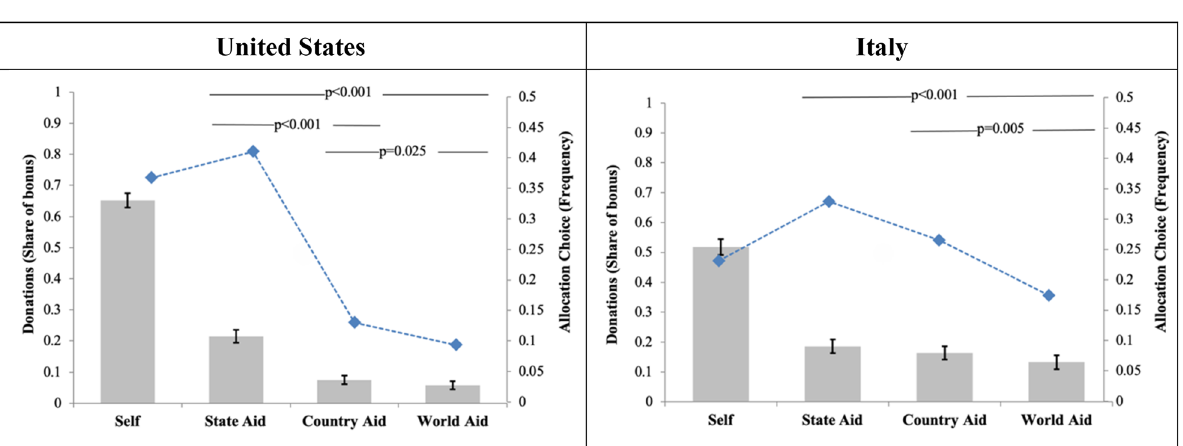
Figure 3. Patterns of bonus allocation. The frequency with which each charity is selected (blue diamonds, scale on the right-hand y-axis) and the mean levels of aggregate donations ( AD ) to each charity and the amount kept for self (bars, scale on left-hand y-axis) are plotted. Whiskers indicate the confidence intervals for mean AD , obtained from bootstrapped standard errors with 10,000 repetitions. The p -values report significance levels of t-tests on the null hypothesis of equality of pairs of coefficients estimated in Supplementary Table 4, columns 1–2. Significance levels for pairwise tests between allocation to self and contribution to charities, which are in all cases significant at p < 0.001, are not